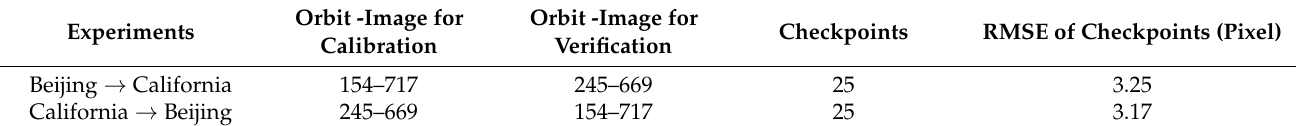
Table 2. Single-image verification results of different orbit data.